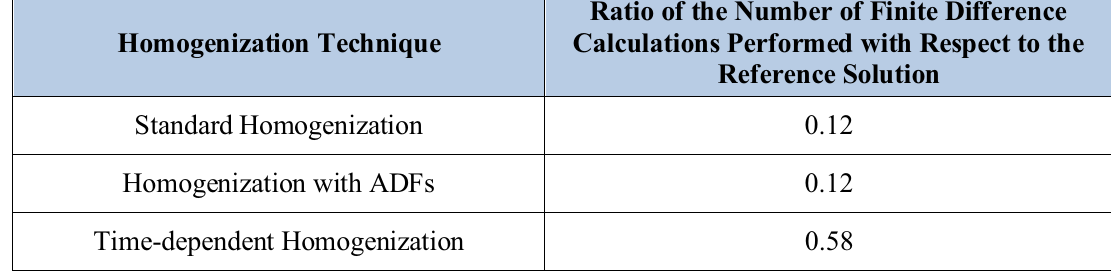
Table VI. Computational Effort with Respect to the Reference Solution Ratio of the Number of Finite Homogenization Technique